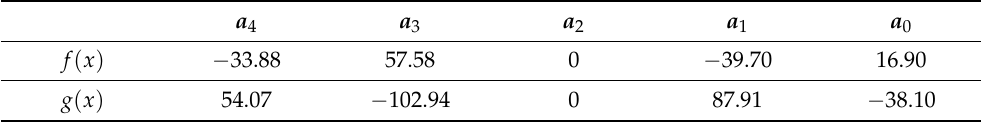
Table 11. Coefficients of the additional functions for